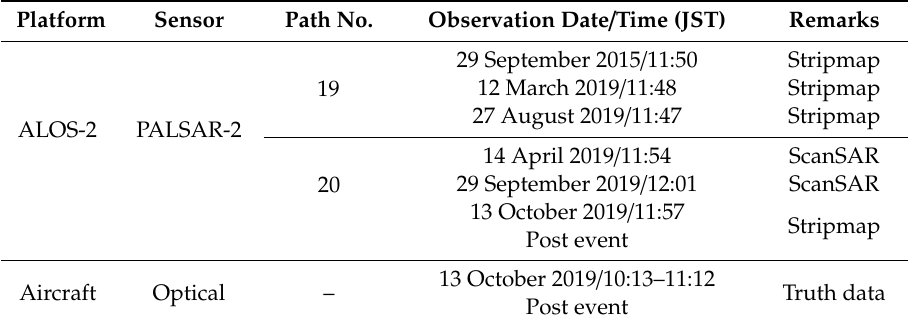
Table 1. List of the datasets used in this paper.